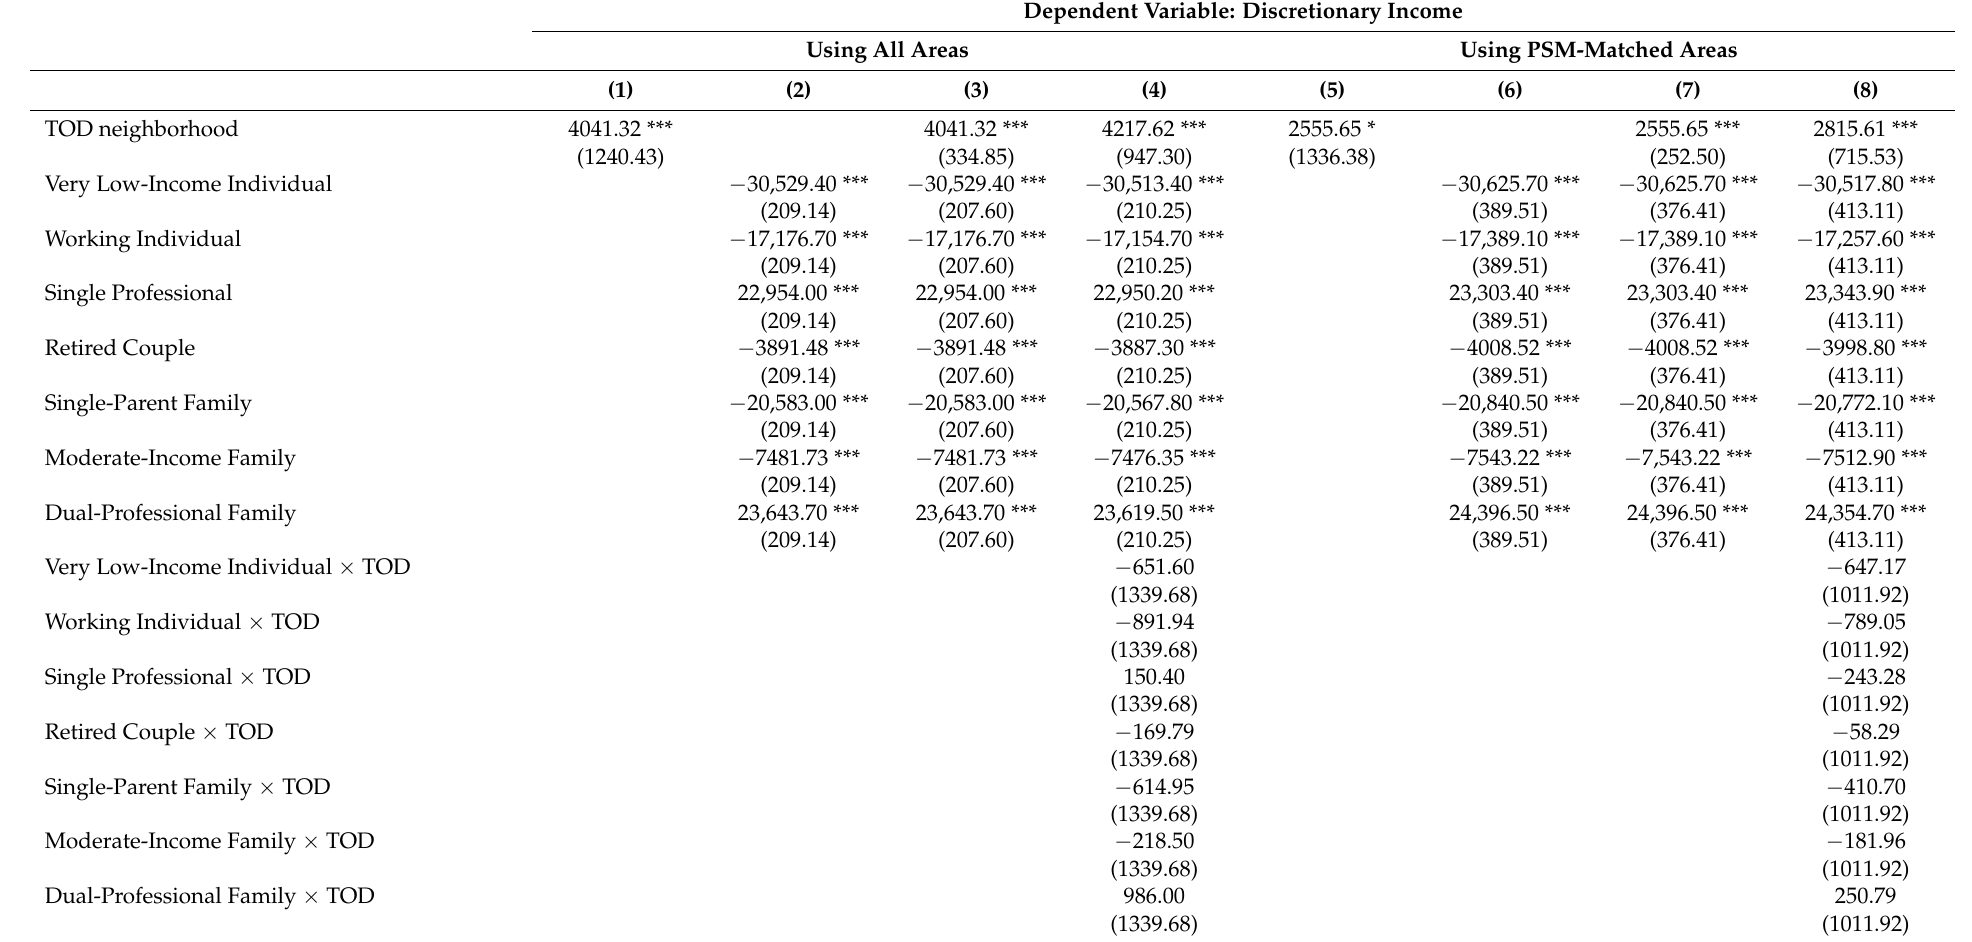
Table 4. Discretionary income